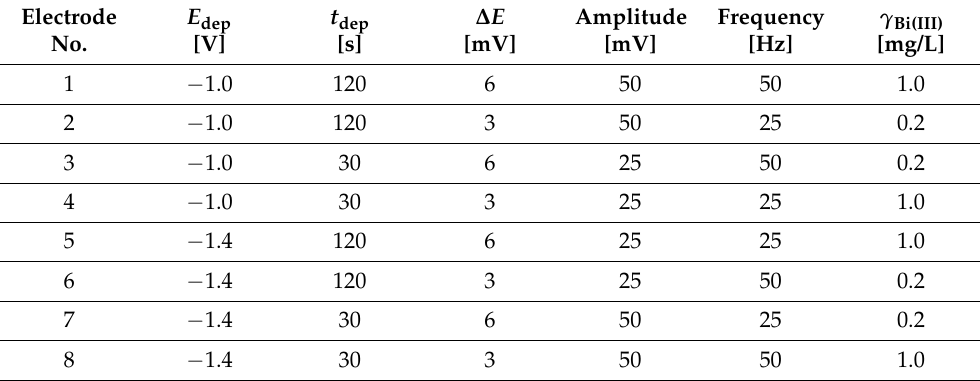
Table 1. Fractional two-level factorial design with six factors (the values of the factors at their high and low levels).